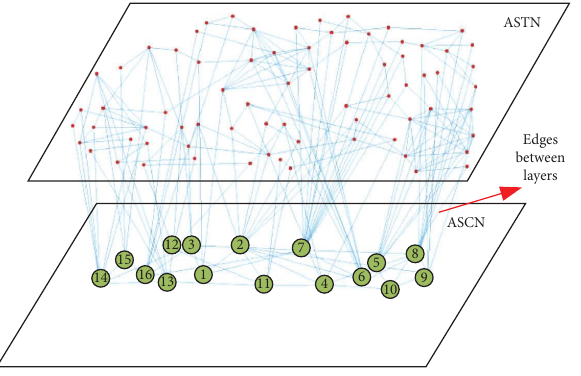
Figure 10: Te ACMN